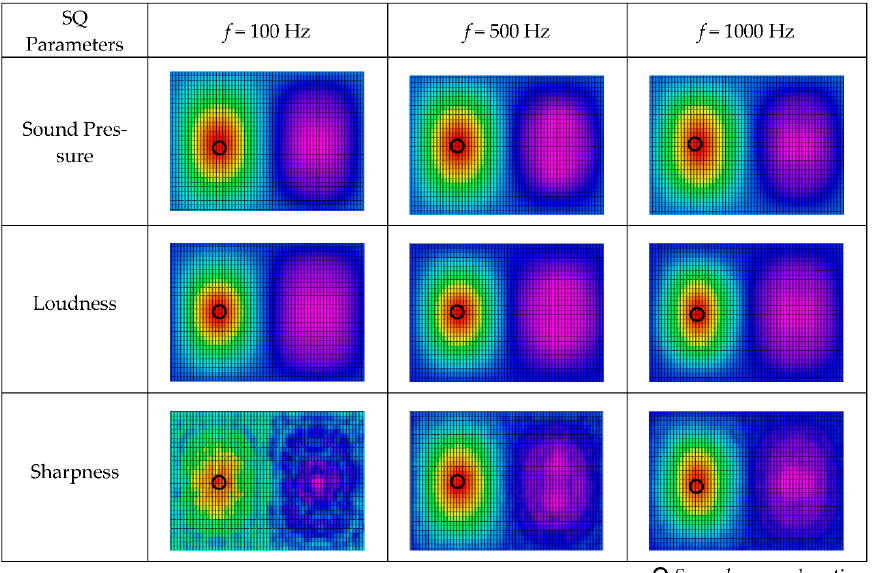
Figure 5. Spatial distribution of sound quality (SQ) objective parameters for source frequency f = 100 Hz at different re- construction distances. (The results are shown in the form of plane expansion of the spherical calculation surface, and the horizontal axis is longitude: −π ~ π , the vertical axis is latitude: −π /2~ π /2).